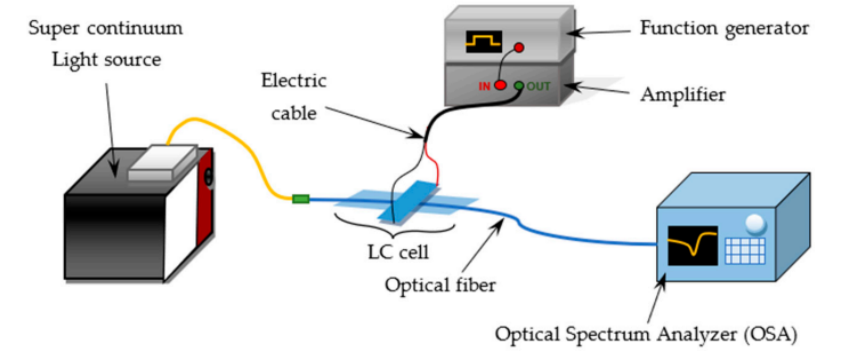
Figure 5. Scheme of the measuring system.